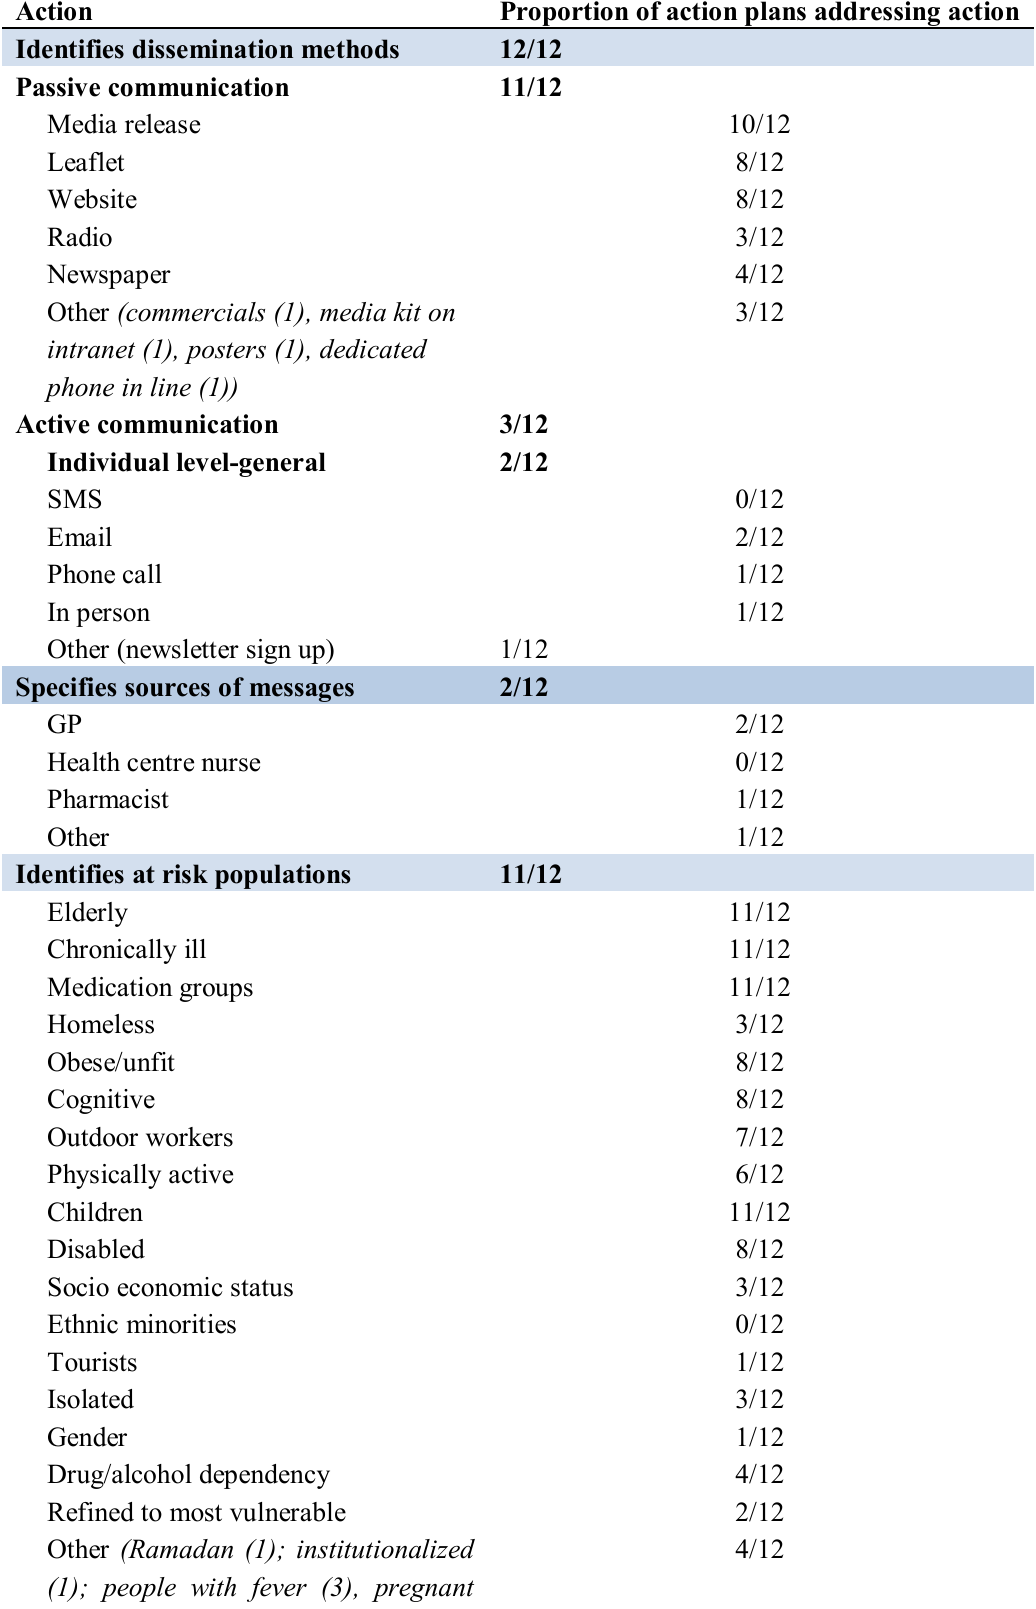
Table 4. Communication, notification and prevention actions outlined in the HEWS.